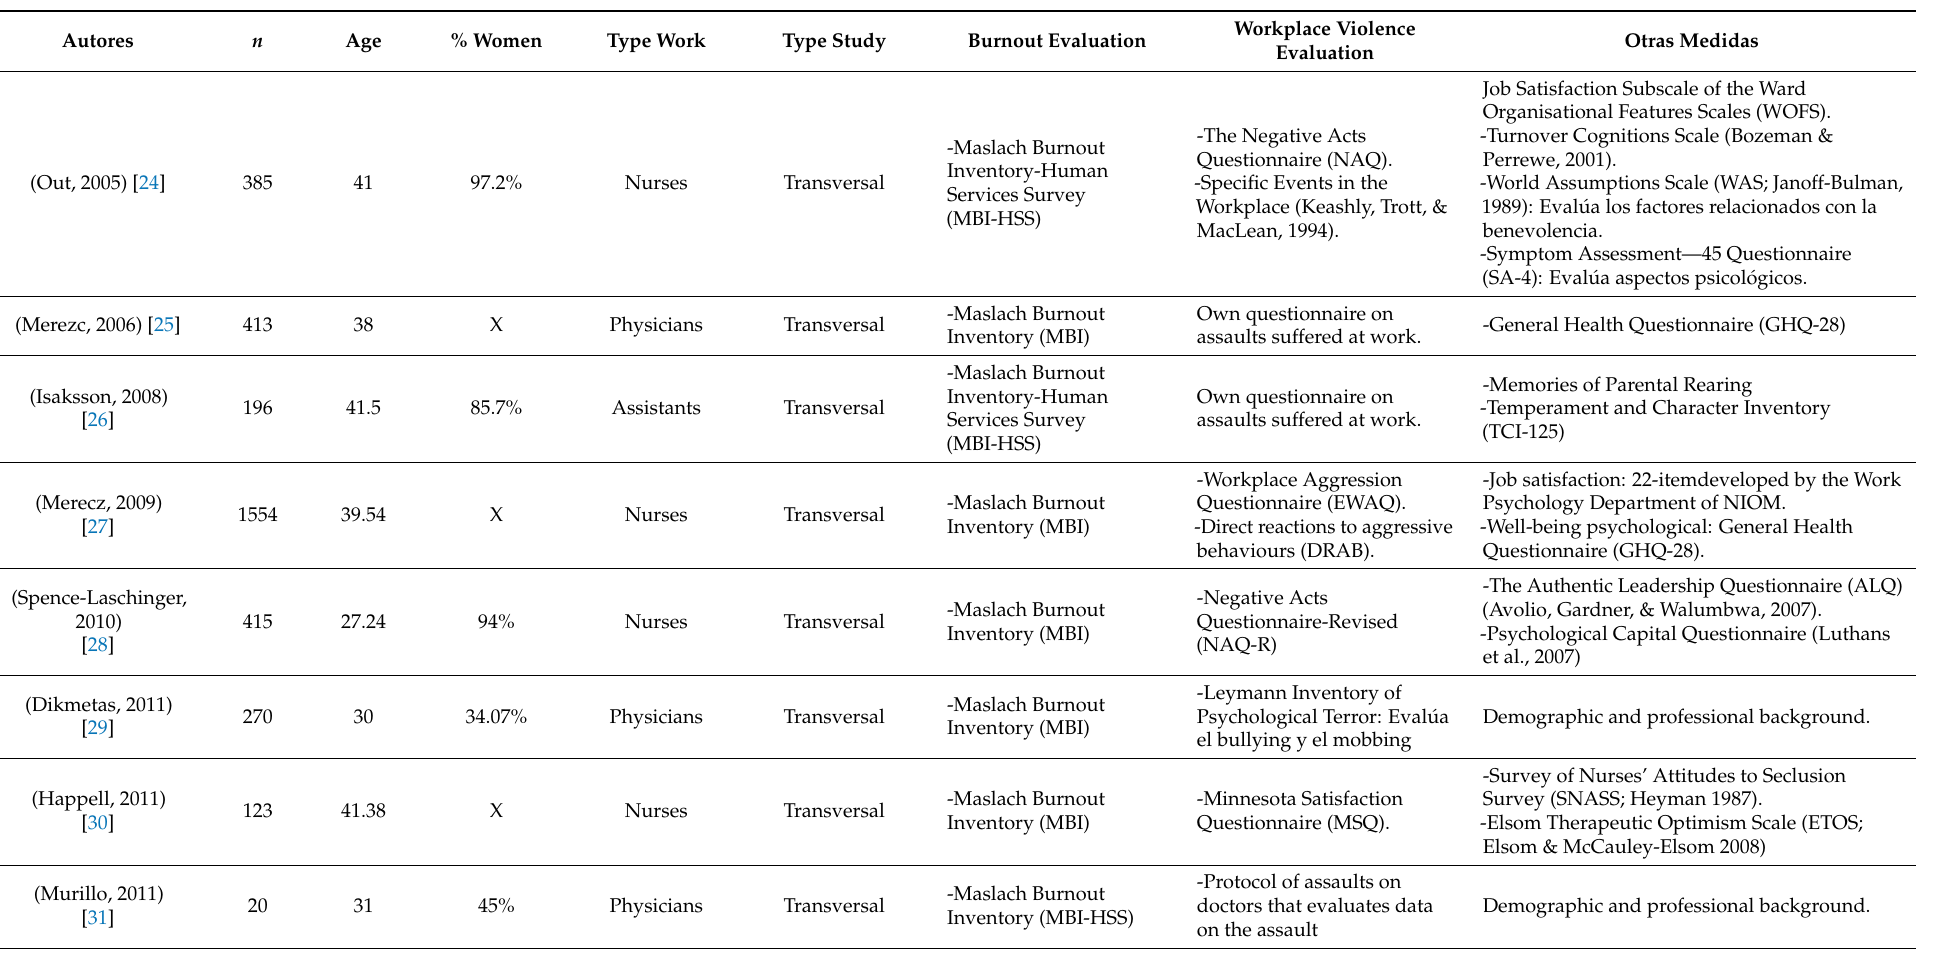
Table 1. Description of the included